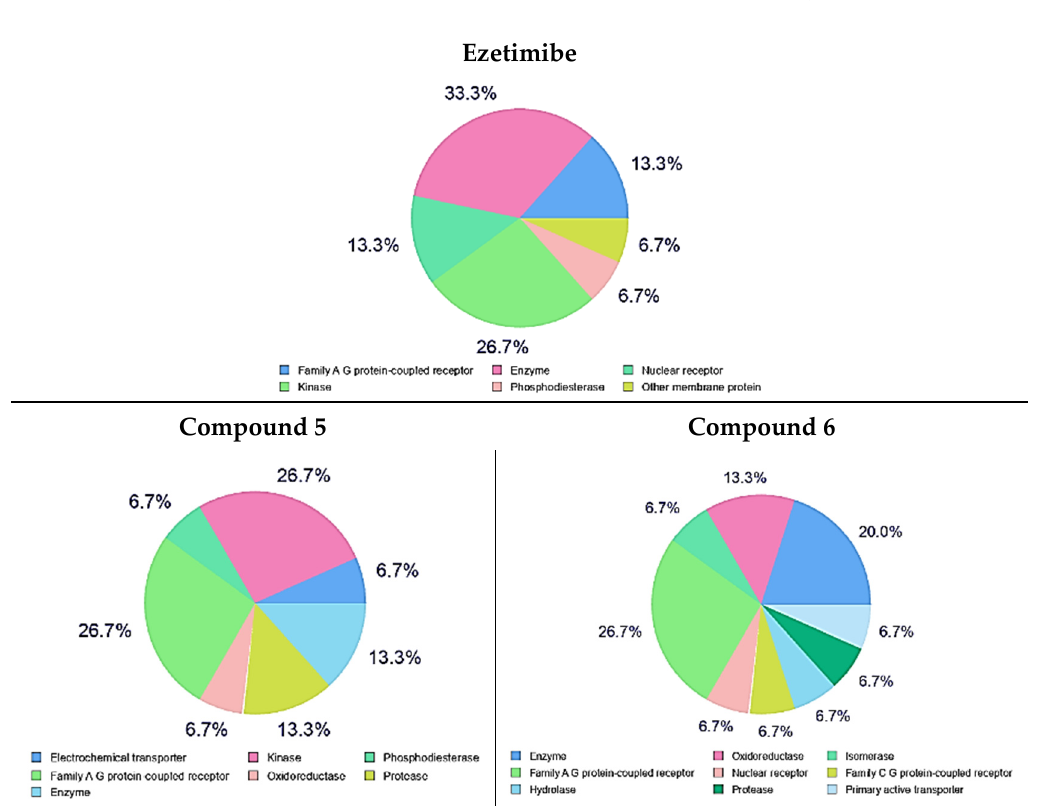
Figure 10. Top 15 drug targets of compounds 5 , 6 and Ezetimibe as predicted using Swiss Target Prediction.